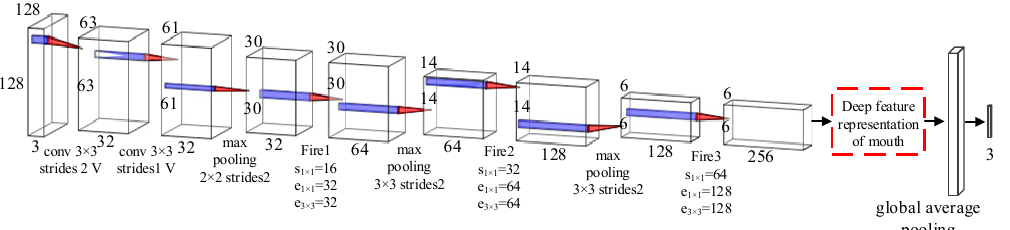
Figure 3. Illustration of the mouth state detection model. The red boxes drawn with a dotted line define the extracted deep features representation of the mouth. The numbers next to the boxes illustrate the dimensionality and structural detail of the kernel in each convolutional layer.